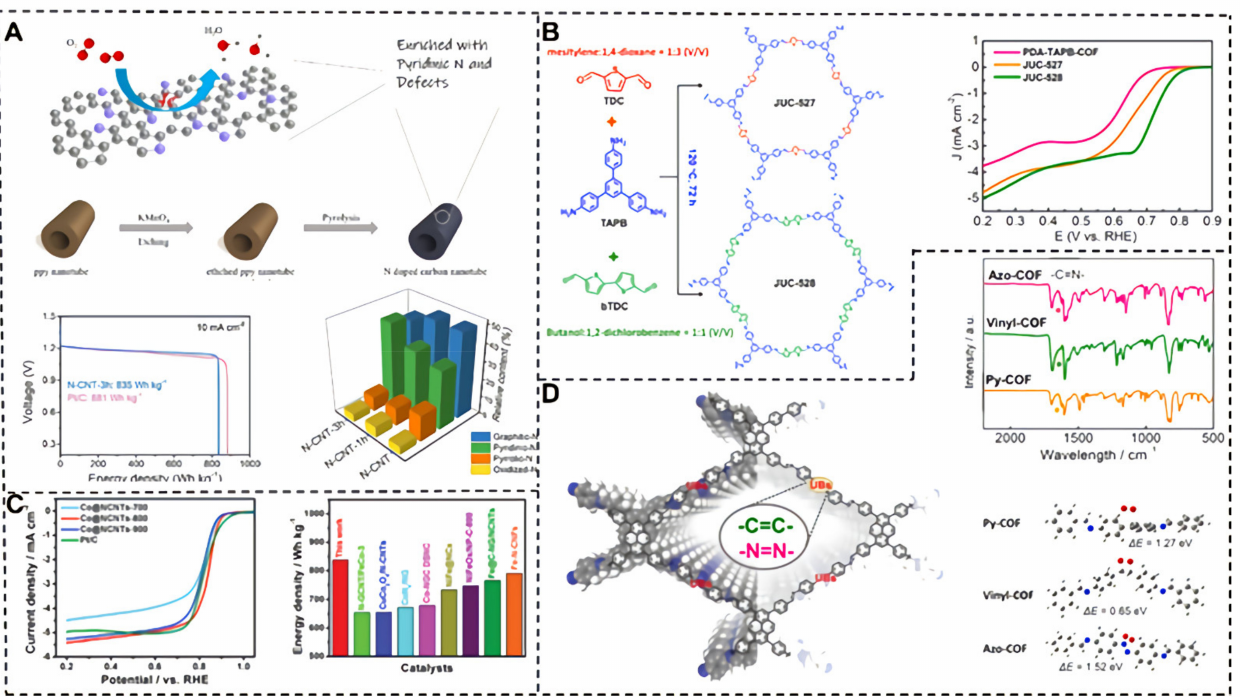
Figure 3. ( A ) Schematic diagram of the prepared N-doped carbon nanotubes and energy density of Zn-air battery [29]. ( B ) Structures and synthetize of JUC-527 and JUC-528,and the LSV curves of JUC-527, and JUC-528 [31]. ( C ) LSV curves for the ORR, and the energy density of